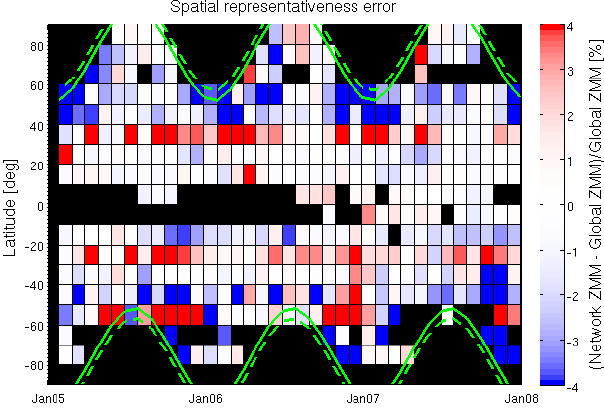
Figure 7. Simulated differences between zonal means based either on data coincident (in geolocation) with ground-based reference in- struments, or on full global gridded data. These differences consti- tute the so-called spatial representativeness error. Data used for this graph are 6-hourly modelled fields calculated with IFS-MOZART for MACC (Inness et al., 2013). The green solid and dashed lines correspond to 75 and 80 ◦ solar zenith angles at noon,